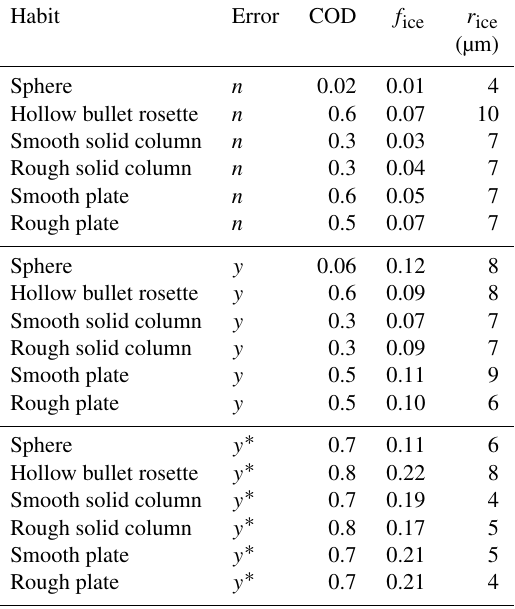
Table 6. Root-mean-square errors in retrieved cloud properties, as- suming a spherical ice habit, for ice clouds of varying habit (first column): cloud optical depth (COD), ice fraction ( f ice ), and effec- tive radius of ice ( r ice ). For the upper set of cases, errors were not imposed (error = n ) and true cloud heights were used. The mid- dle set of cases includes imposed error with true cloud heights (er- ror = y ), while the lowest set includes imposed errors with retrieved cloud heights (error = y ∗ ; see